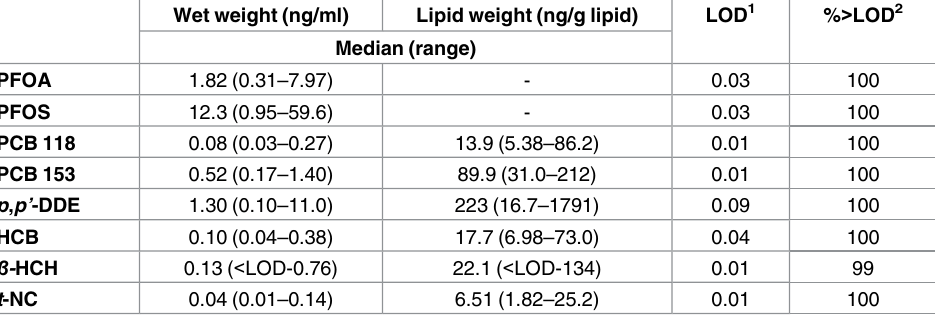
Table 2. Maternal serum levels of PFASs (ng/ml) and OCs (ng/ml and ng/g lipids) in the SGA study (N =